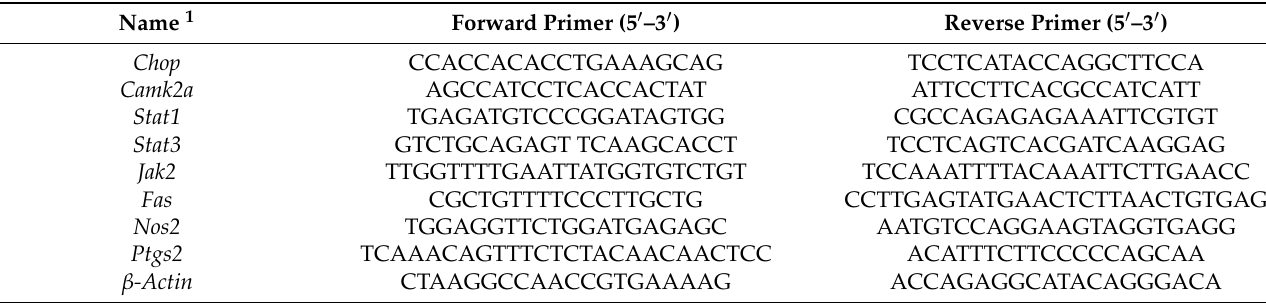
Table 1. Primers used for quantitative